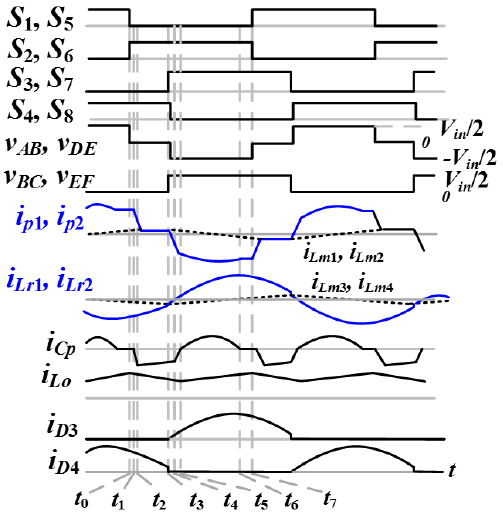
Figure 3. PWM waveforms of the proposed circuit.